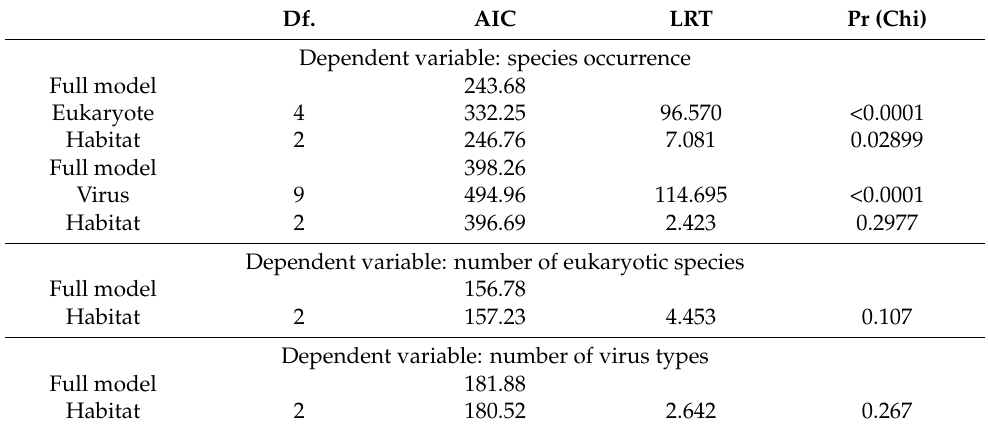
Figure 2. The comparison of proportion of eukaryotic pathogen occurrence regardless of habitat. Black squares represent means and the error bars represent 95% confidence intervals. Significant differences (<0.05) are indicated by different letters.